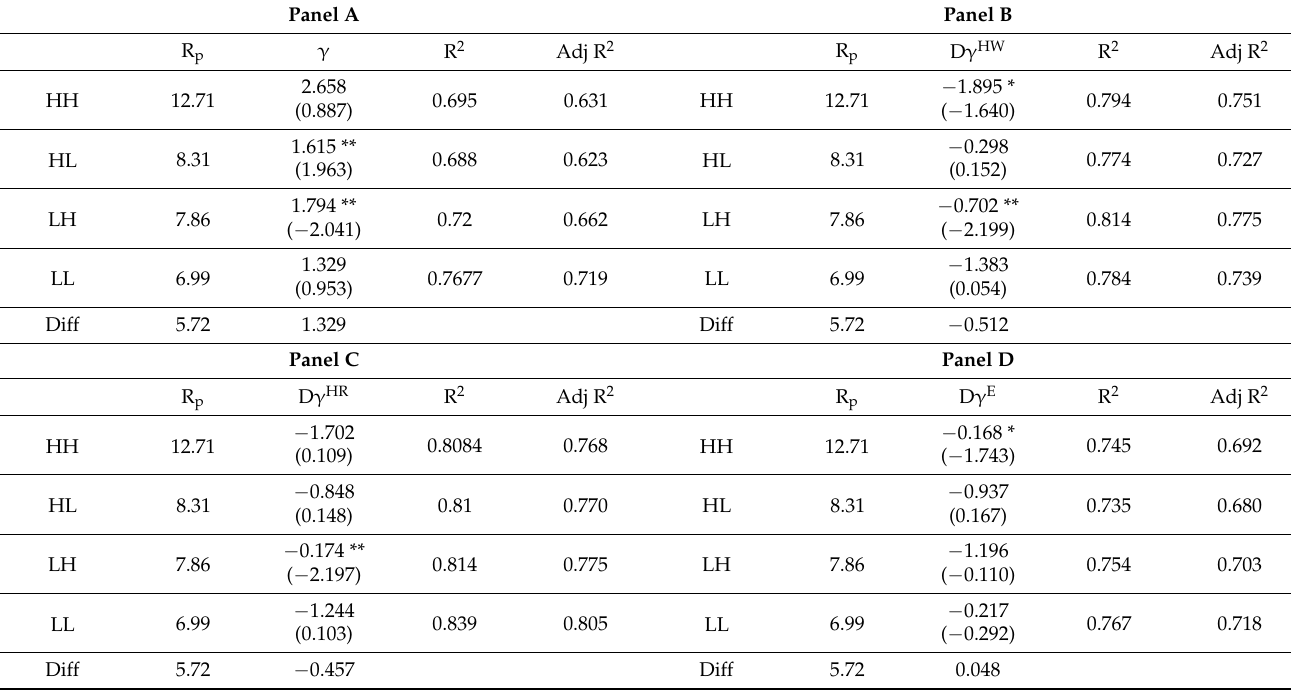
Table 2. Results for γ , D γ HW , D γ HR , and D γ E with R 2 and Adj R 2 and their t -stat in ( ). Diff is the difference of returns between HH and LL for γ , D γ HW , D γ HR , and D γ E showing the risk–return